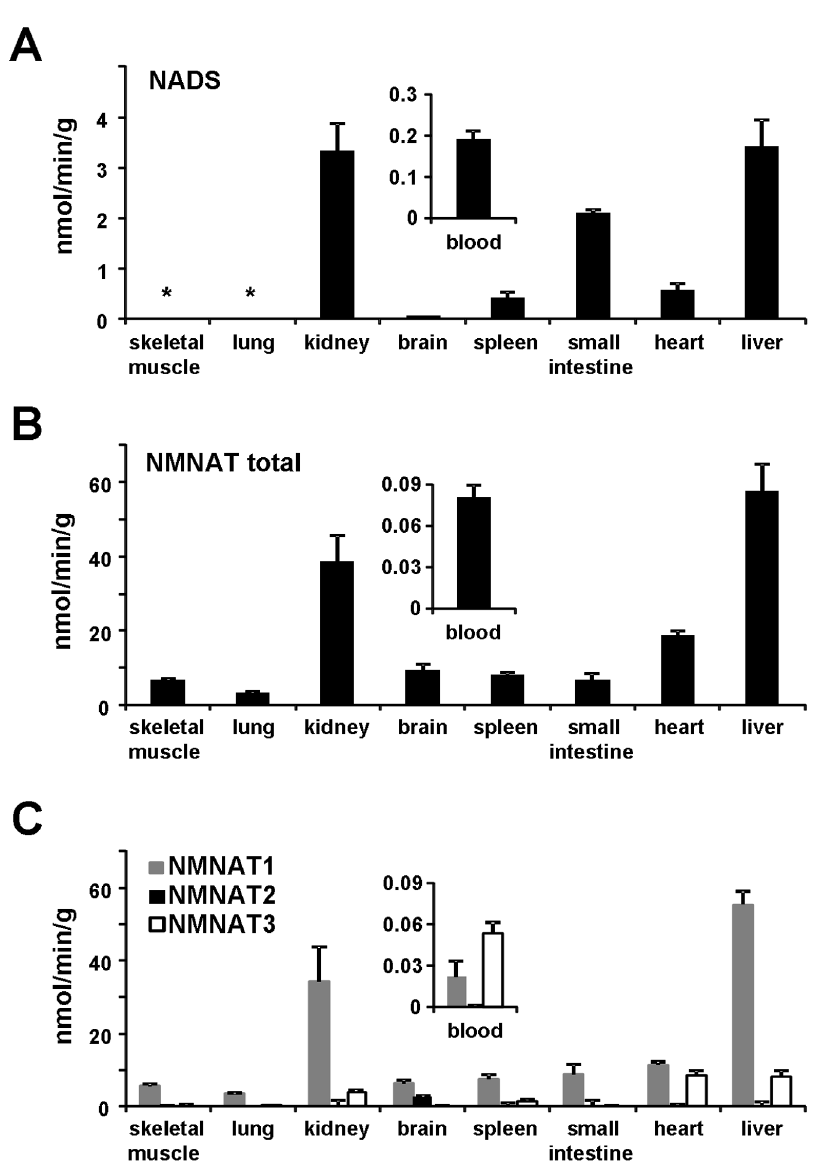
Figure 3. In vitro activity profiling of NMNAT and NADS in mouse tissues. A, NADS activity; B, total NMNAT activity; C, isozyme-specific NMNAT activity. Insets show in an amplified scale the activity profile of whole blood. Rates were measured at a saturating concentration of all substrates, and represent the mean ¡ standard error from at least duplicate analysis. (*) not detectable ( i.e. , # 0.005).